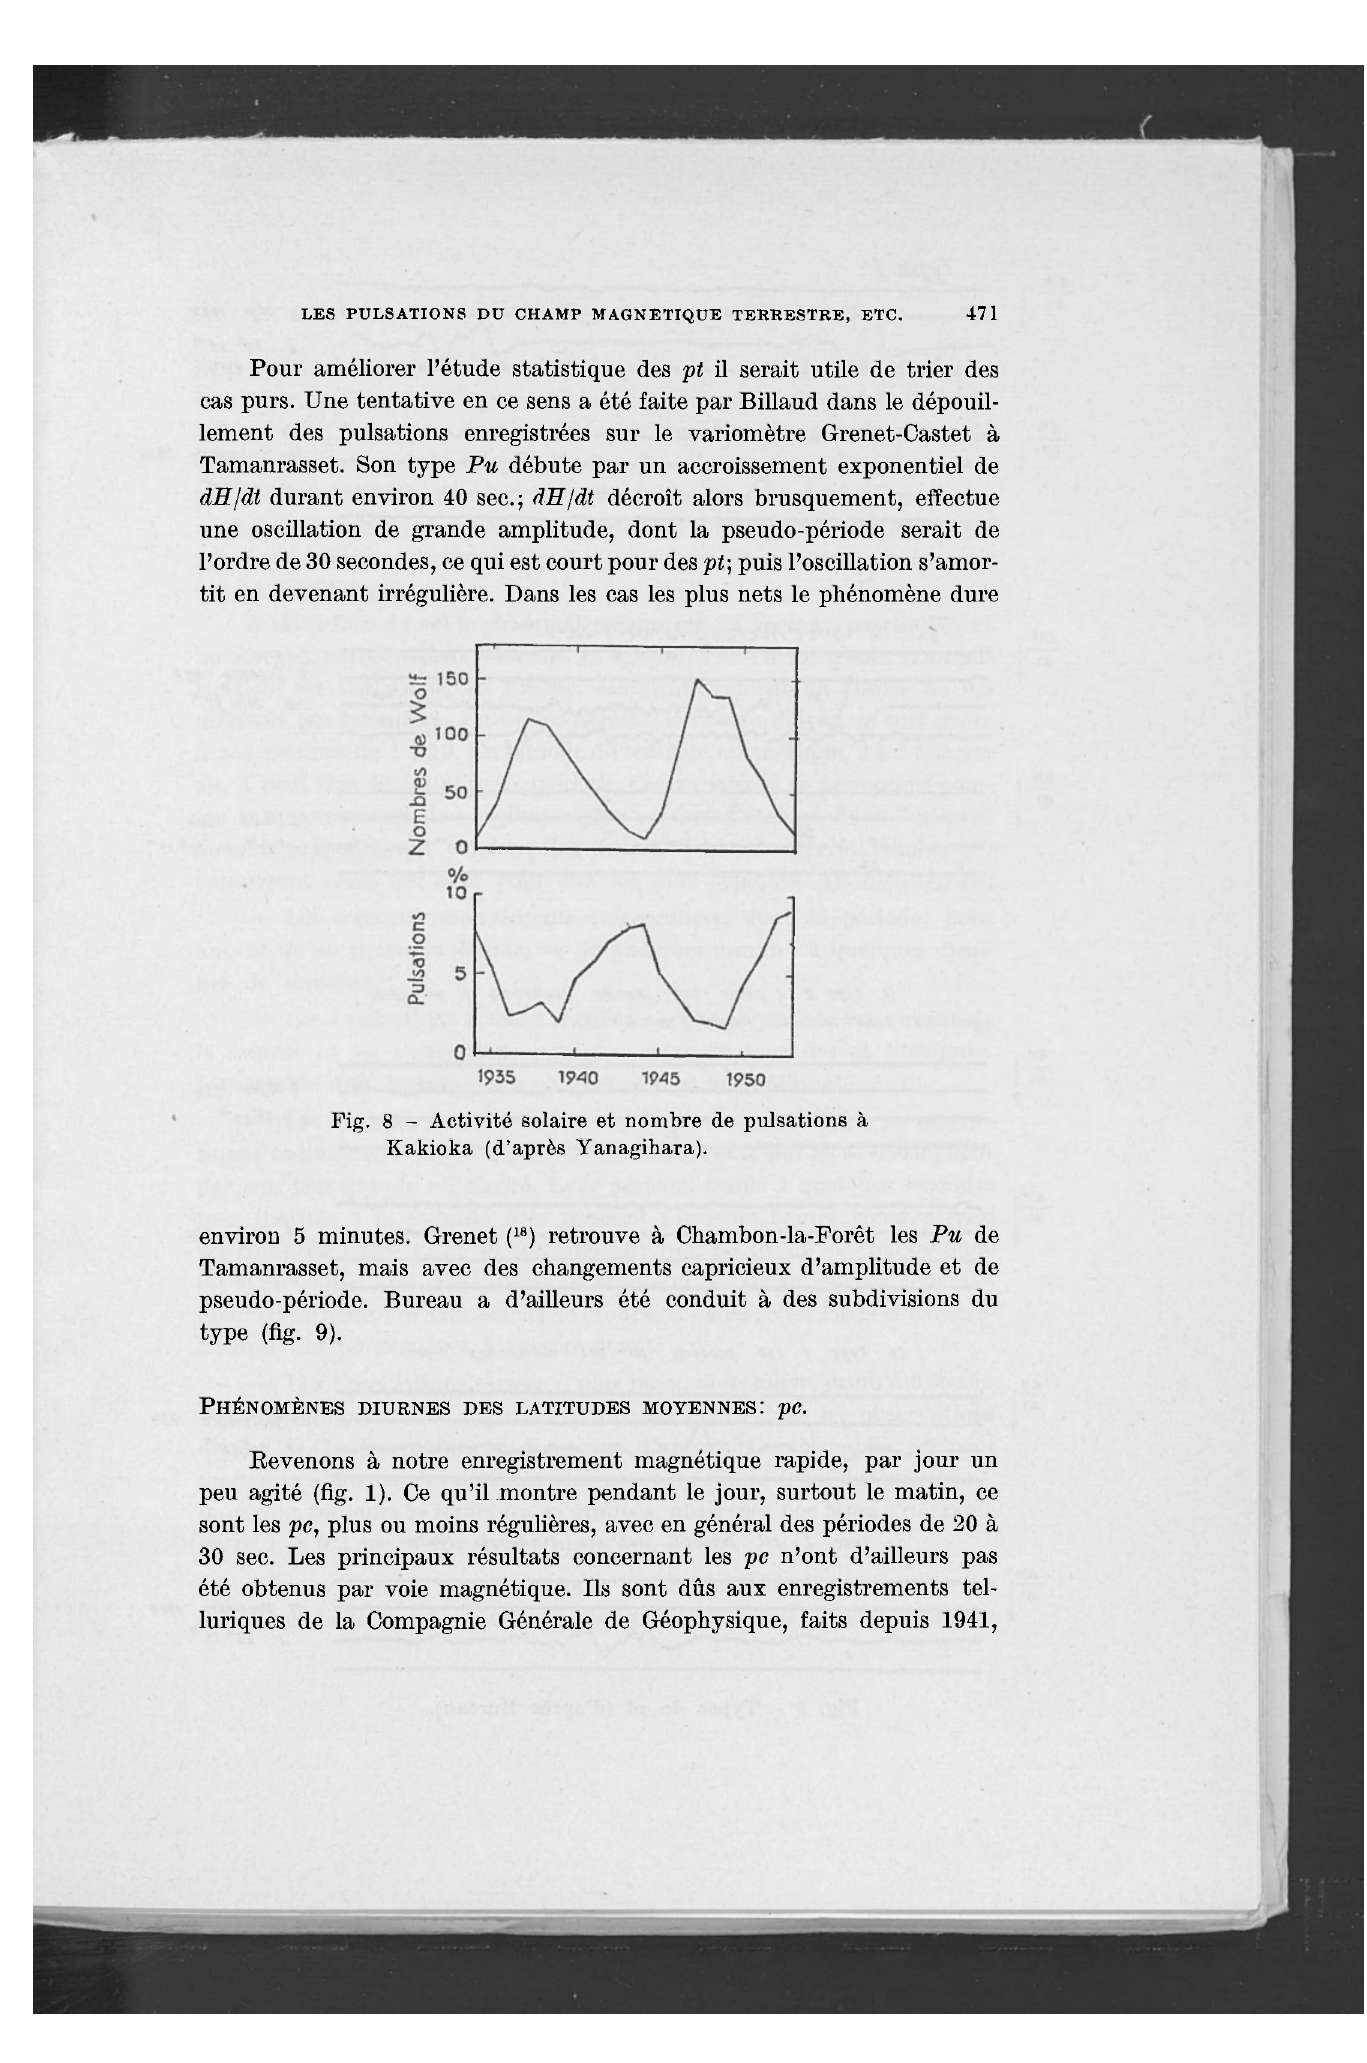
Fig. 8 - Activité solaire et nombre de pulsations à Kakioka (d'après